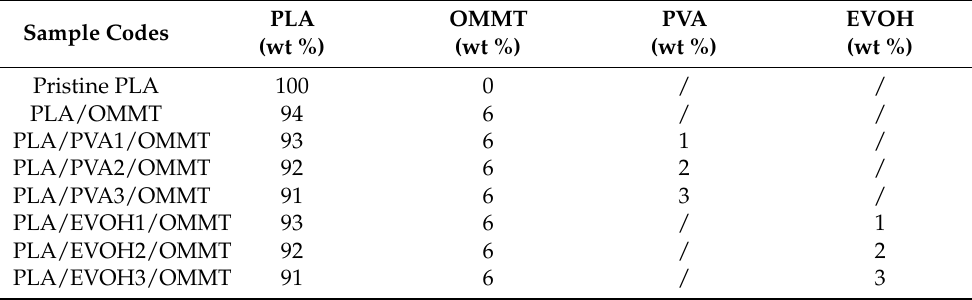
Table 1. The weight percentages of different compounds used for the preparation of PLA/OMMT